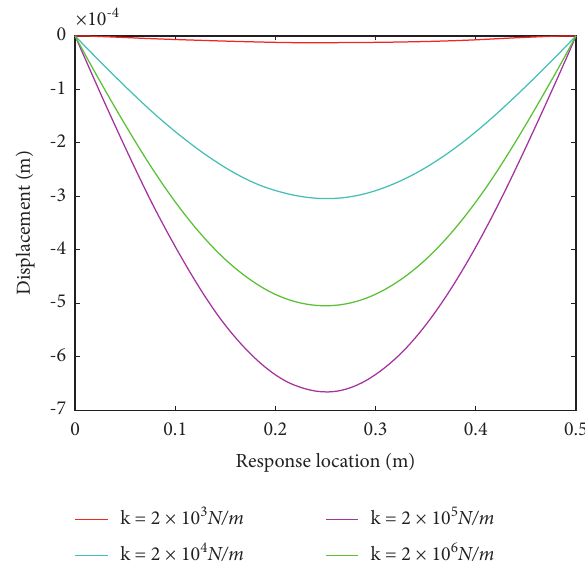
Figure 21: Vibration shape of beam 2 under different support stiffnesses.